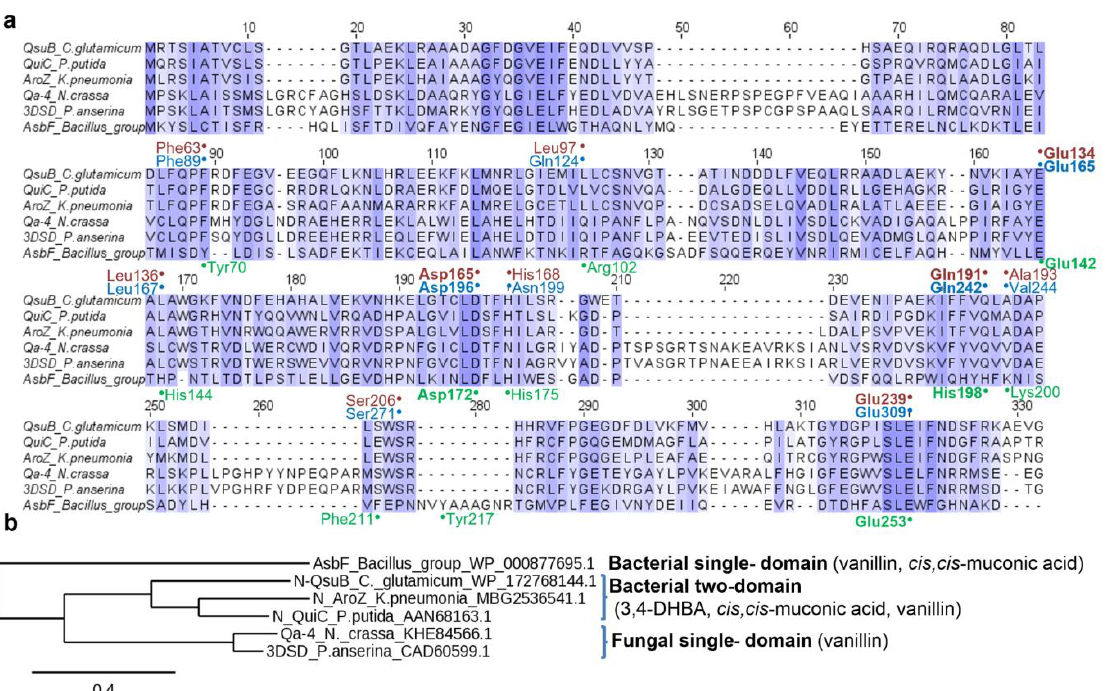
Figure 3. Amino acid alignment ( a ) and a phylogenetic tree ( b ) of DSDs used for the microbial production of 3,4-DHBA and the compounds derived from 3,4-DHBA (noted in brackets). Amino acid residues written in green (below the row), red, and blue (above the row) correspond to AsbF, QsuB, and Qa-4 active center residues, respectively. Bold font indicates residues participating in metal binding.